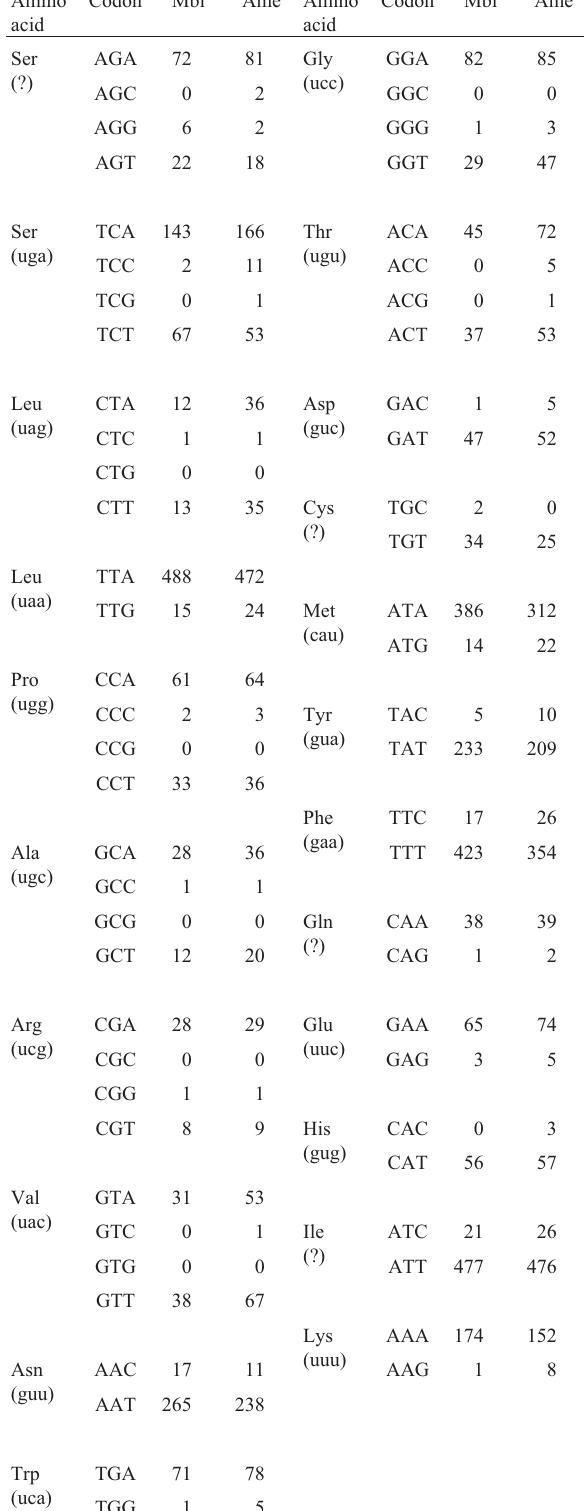
Table 5 - Mitochondrial codons and the absolute number of occurrences on the set of protein-coding genes of M. bicolor (Mbi) and A. mellifera (Ame). The anticodon of the corresponding tRNA are presented in paren- thesis and ? indicates the anticodons not determined for M. bicolor